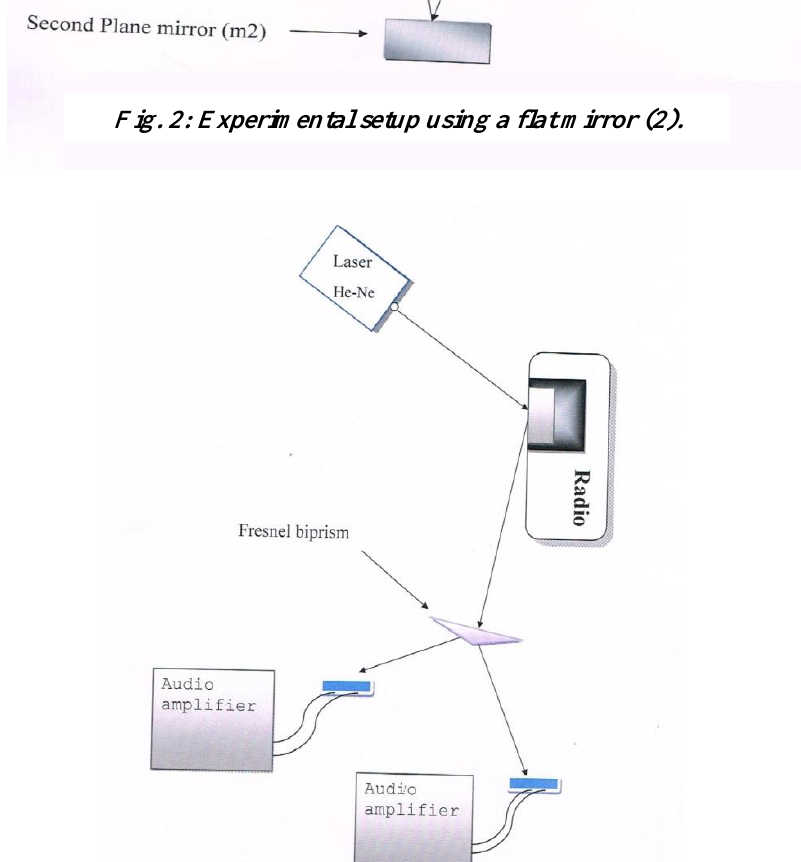
Fig. 2: Experimental setup using a flat mirror (2).